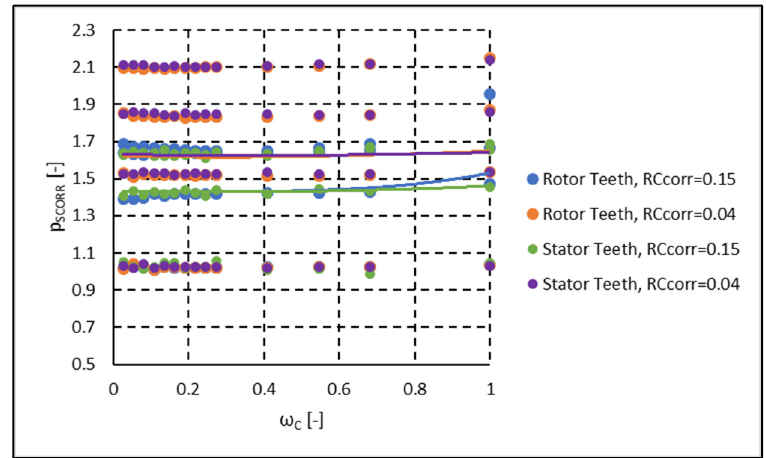
Figure 10. Static pressure trendlines.